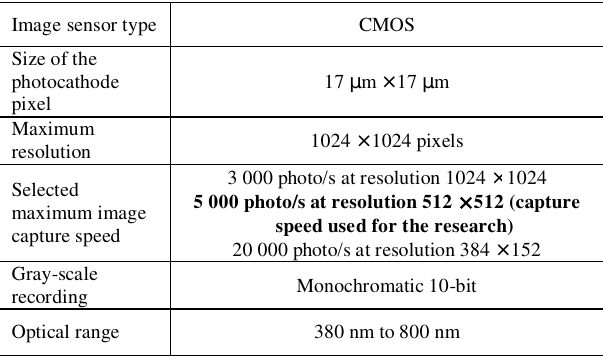
Fig. 6. The rapid compression machine test bench adapted for optical testing in shadow photography (description in the text) Optical tests were performed using a high speed camera, the parameters and selected filming speeds along with the maximum resolution values are shown in Table 1. Table 1. LaVision HighSpeedStar 5 camera parameters [18]